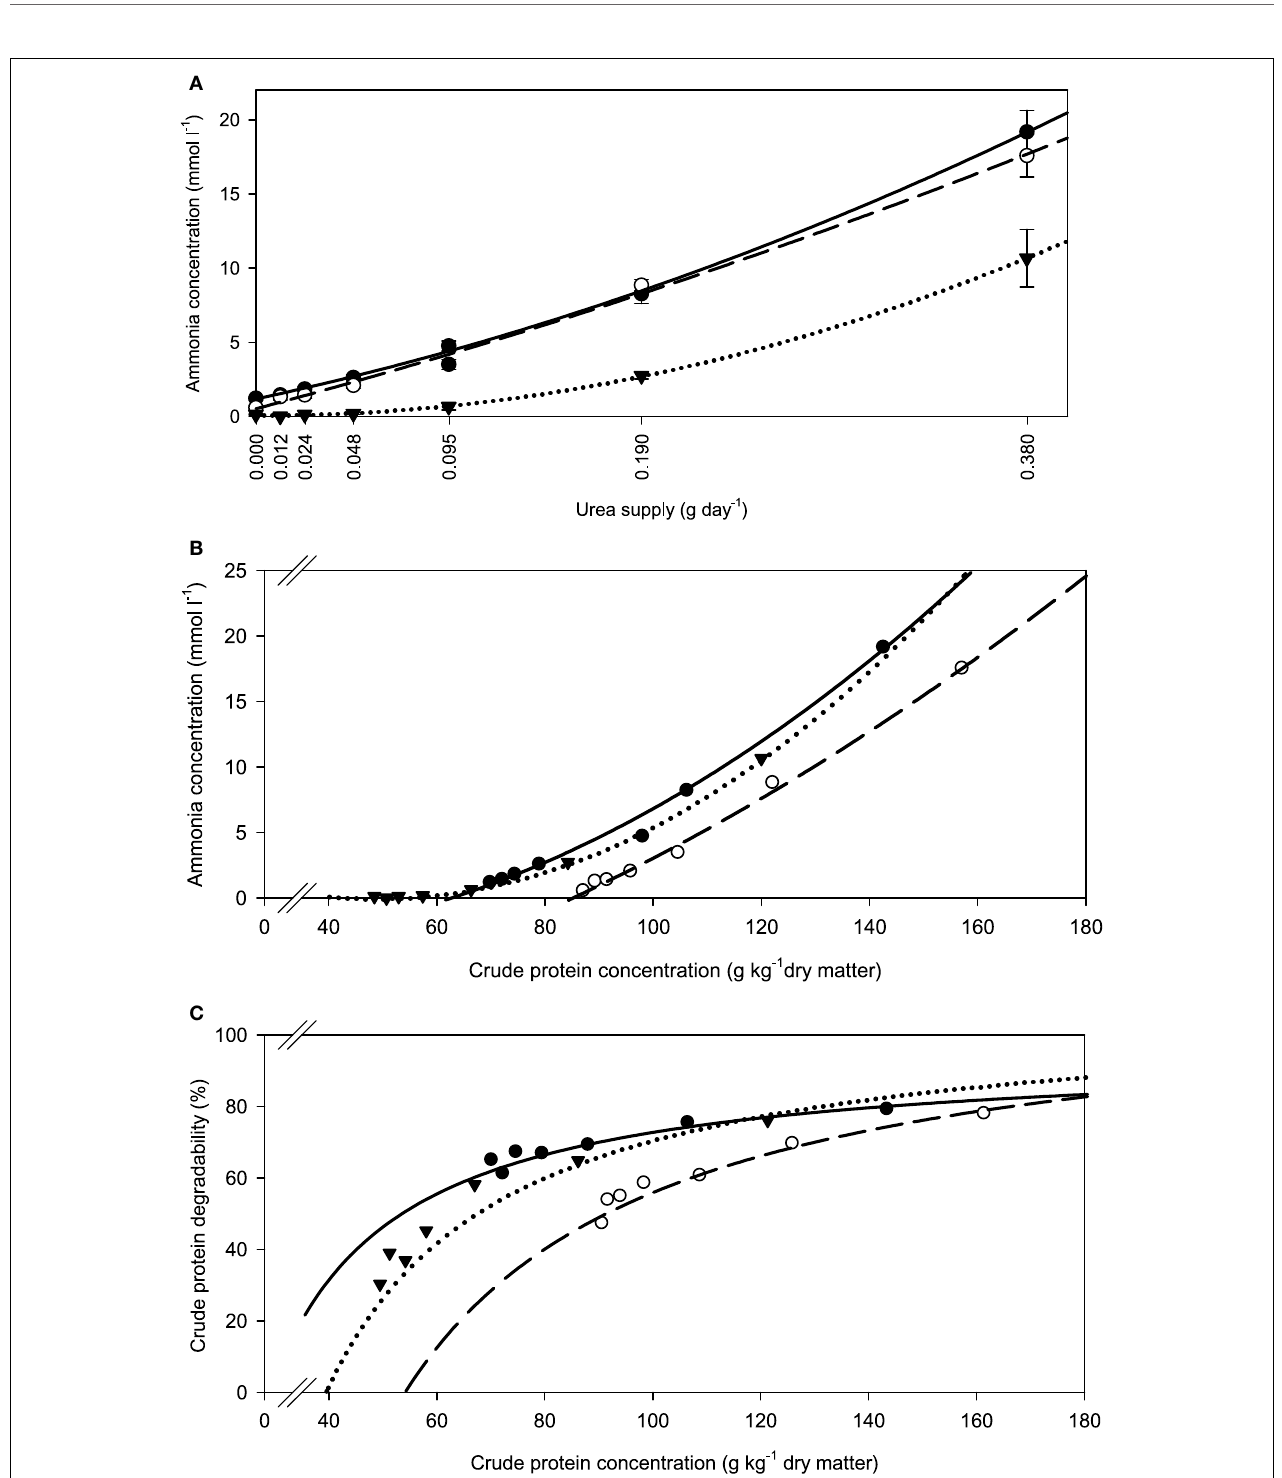
FIGURE 1 | Relationship between (A) incubation fluid ammonia concentration and urea supply, (B) incubation fluid ammonia concentration and dietary crude protein concentration, and (C) crude protein degradability and dietary crude protein concentration. ● brachiaria hay, for (A) y = 1 . 18 ( ± 0 . 134 ; P < 0 . 001 ) + 29.4 ( ± 2 . 47 ; P < 0 . 001 ) x + 47.1 ( ± 6 . 35 ; P = 0 . 0018 ) x 2 , R 2 = 1 . 00 , SE = 0 . 217 , P < 0 . 001 , (B) y = 4 . 58 ( ± 4.56; P = 0 .372) − 0 . 191 ( ± 0.0922; P = 0 . 107 ) x